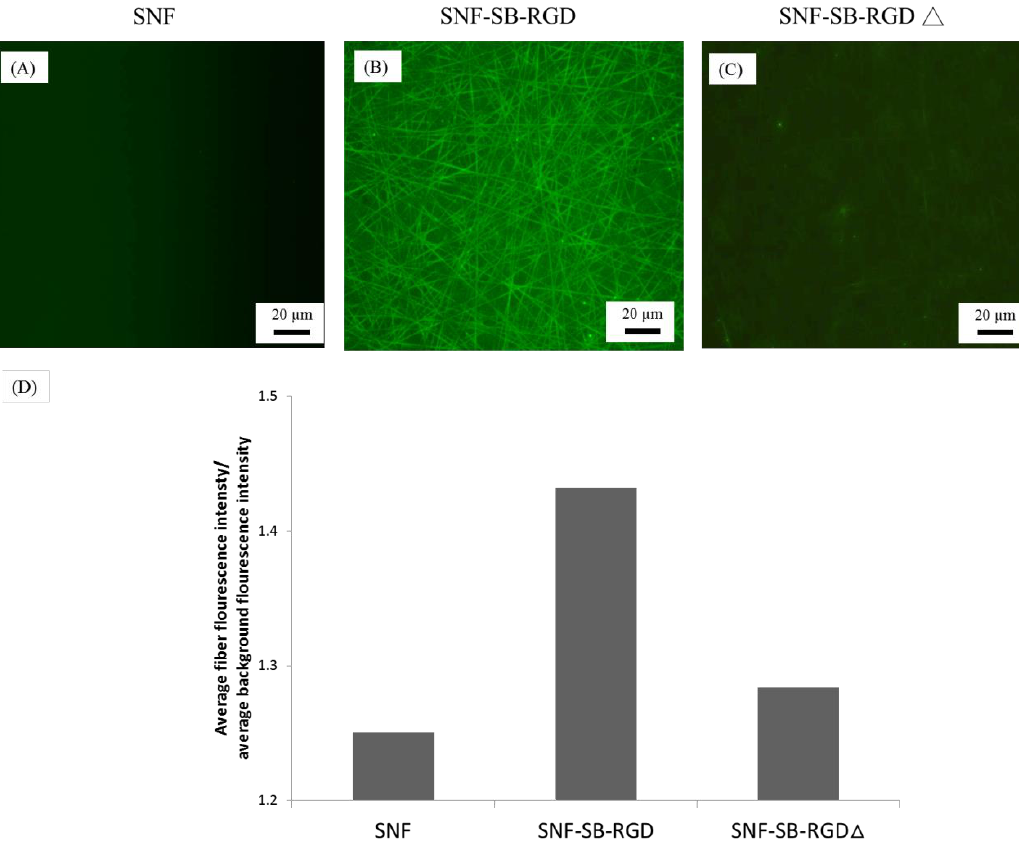
Figure 5. Fluorescence images of the SNF substrates coated with SB-RGD or SB-RGD ∆ (95 ◦ C, 15 min) immunostained with the anti-his tag antibody. ( A ) SNF, ( B ) SNF-SB-RGD, and ( C ) SNF-SB-RGD ∆ . ( D ) Fluorescence analysis of the SNF substrates (n = 10). The scale bars represent 20 μm.